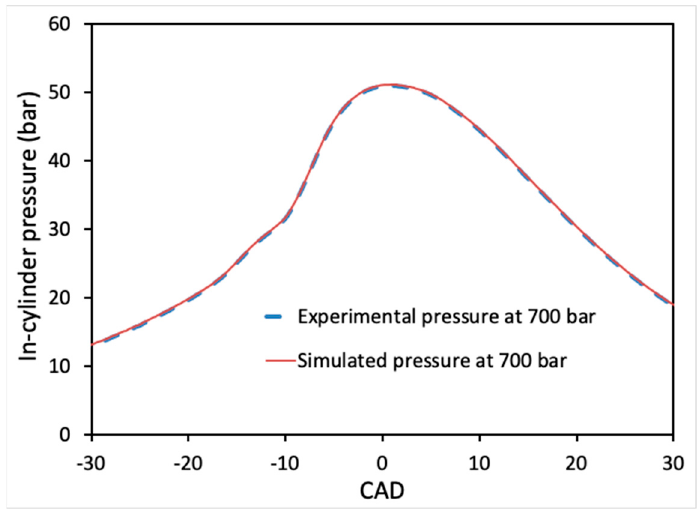
Figure 6. Comparison of the calculated in-cylinder pressure versus CAD with measured data at 1000 rpm and 700 bar.